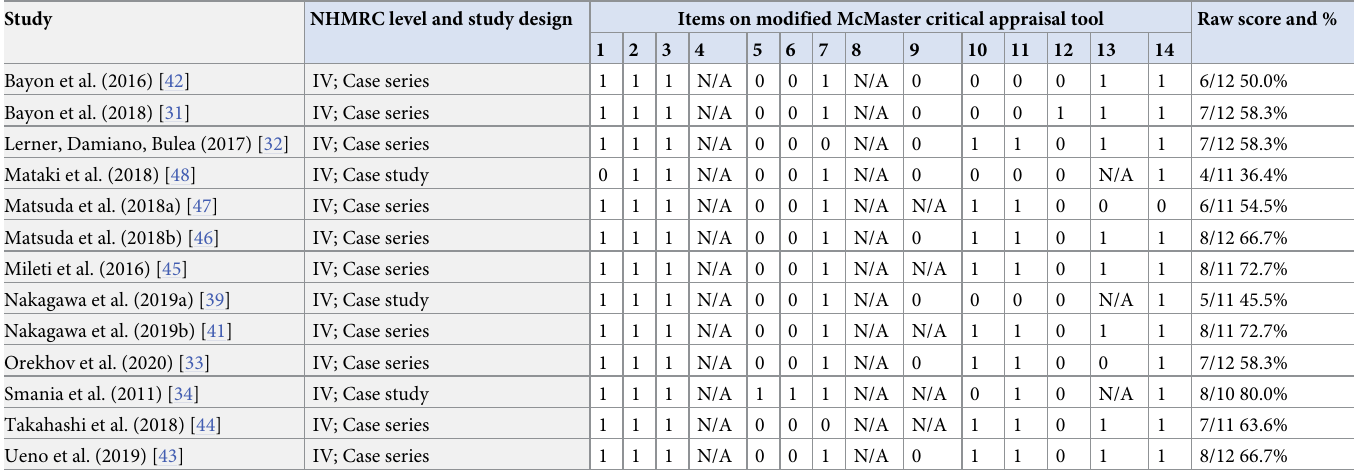
Table 1. Levels of evidence and critical appraisal